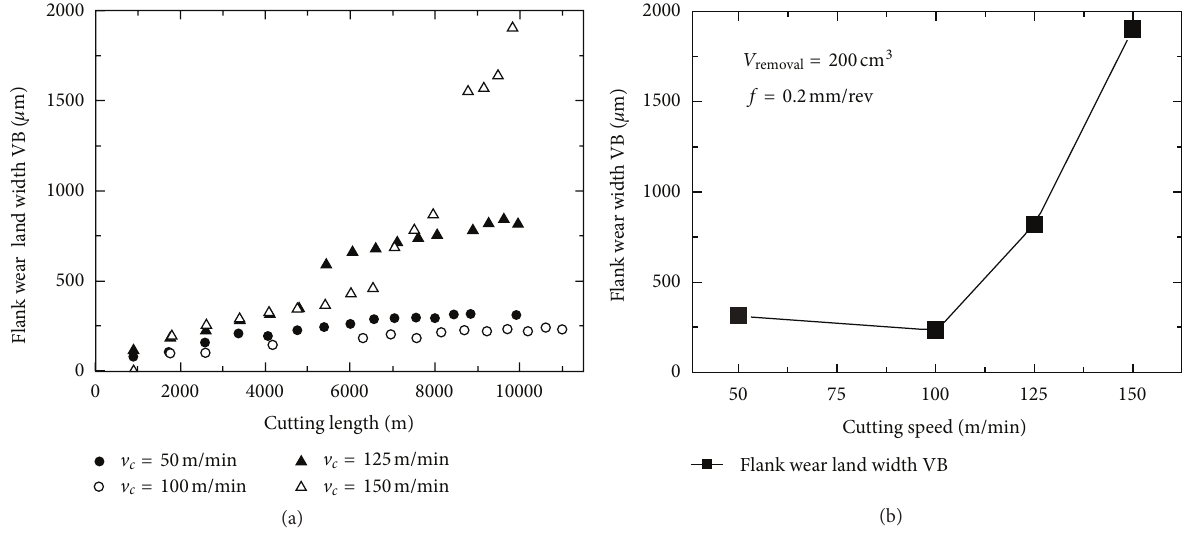
Figure 3: Flank wear land width VB with respect to cutting length (for varying cutting speed 50m/min–150m/min) and constant feed rate and comparison of the final state of tool wear after material removal of 200 cm 3 .